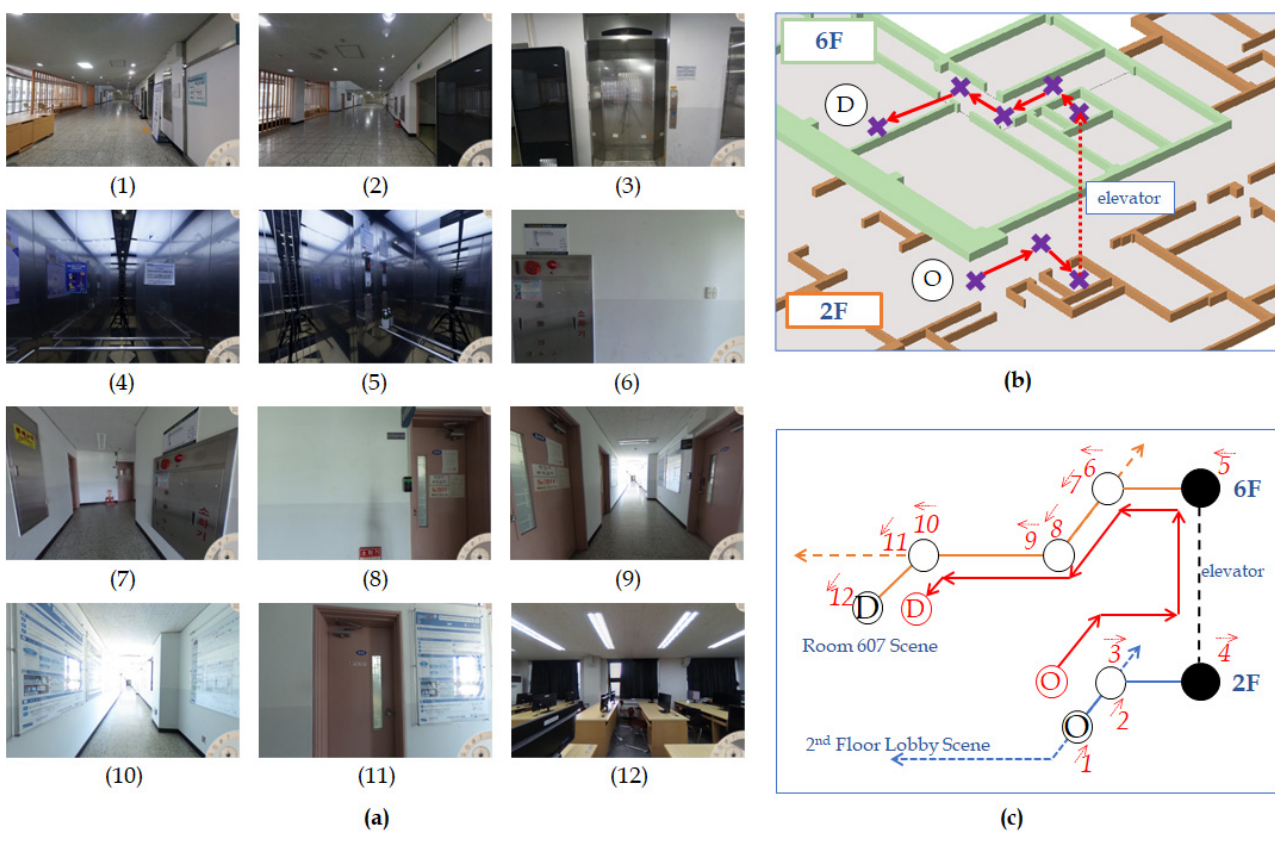
Figure 17. Results of automated navigation visualized on the topology-embedded image data: ( a ) display shown for each portion of the automated navigation; ( b ) route along the portion of the building network; ( c ) visualization of the route with annotated view directions.